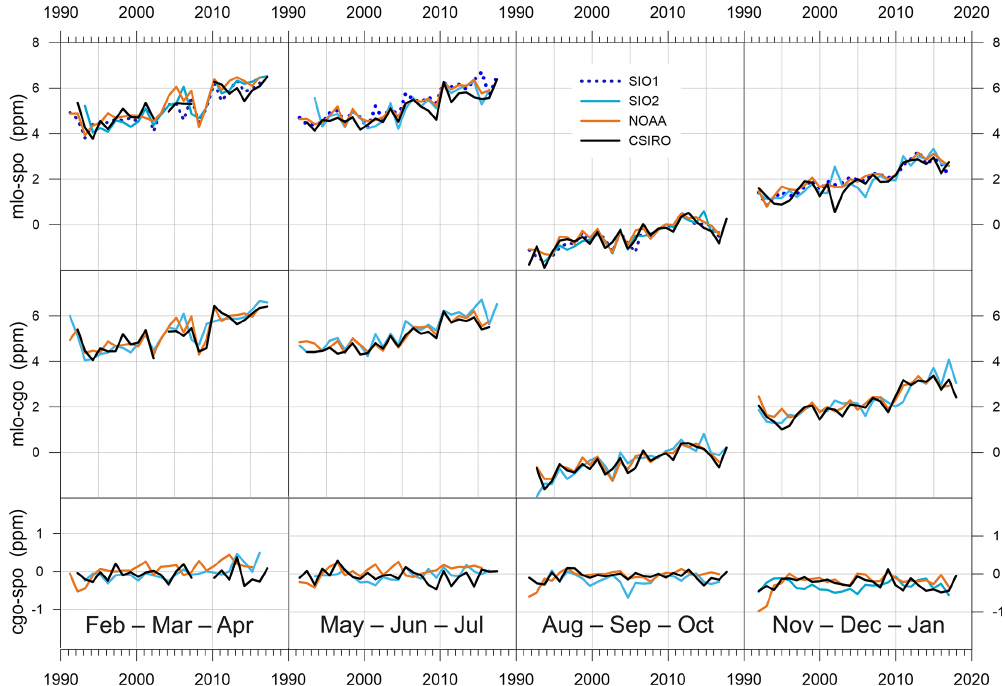
Figure 2. Three-month averaged CO 2 differences between sites for each of the four sampling networks: for years spanning 1990 to 2020.